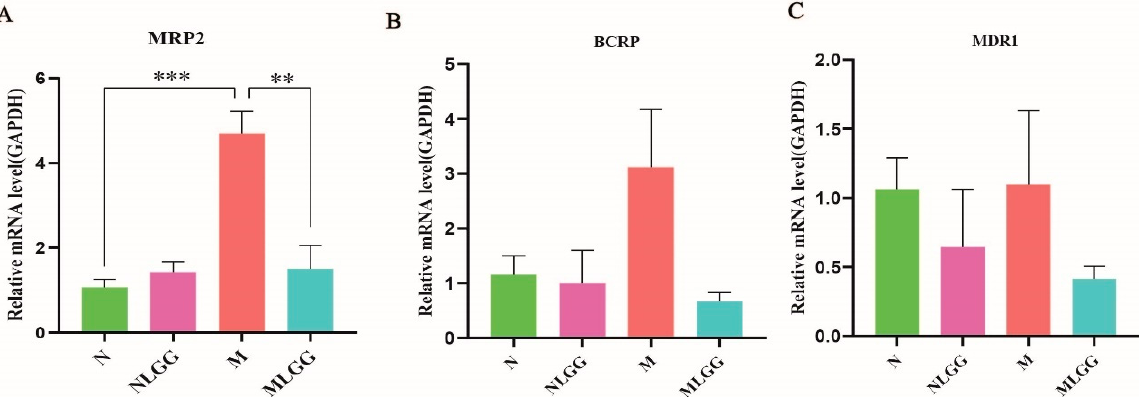
Figure 4. Differences in the relative gene expression of transporter genes in the small intestine in the control group (N group), the control group supplemented with Lactobacillus rhamnosus R0011 ( L. rhamnosus R0011) (NLGG group), the liver cirrhosis group (M group), and the liver cirrhosis group supplemented with L. rhamnosus R0011 (MLGG group). ( A ) Multidrug resistance protein 2 (MRP2). ( B ) Breast cancer resistance protein (BCRP). ( C ) Multidrug resistance gene 1 (MDR1). Data are presented as the mean ± SEM ( n = 6). The data were analyzed via one-way ANOVA (** p < 0.01; *** p <